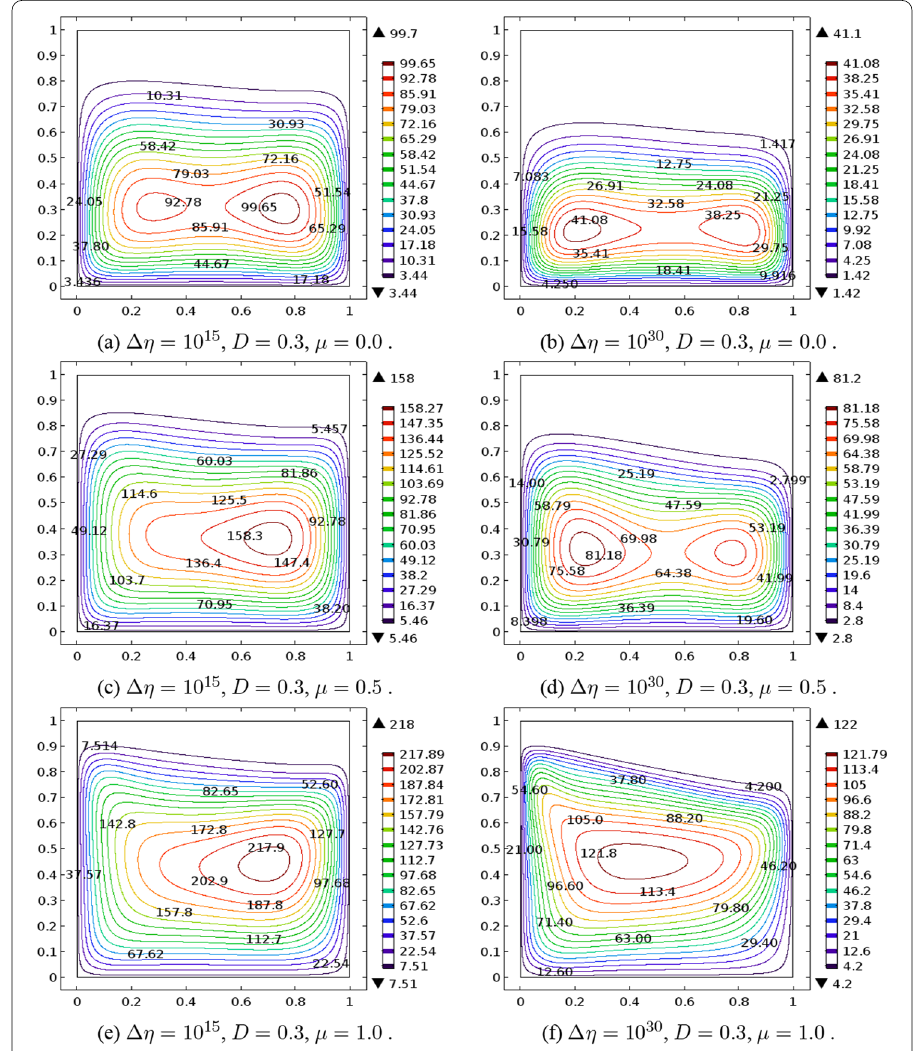
Fig. 4 Stream function contours of a convection at different viscosity variations and at different pressure numbers for a fixed viscous dissipation number D = 0.3 with θ 0 = 0.1 and Ra = 10